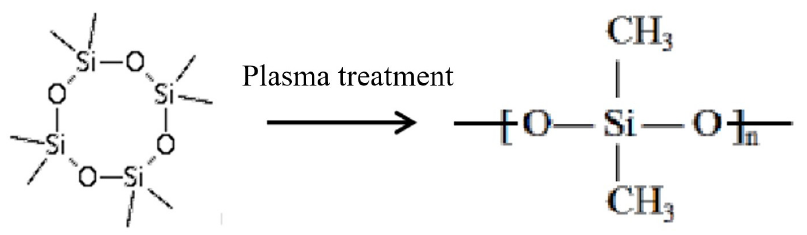
Figure 12. Schematic diagram of plasma graft polymerization D4.